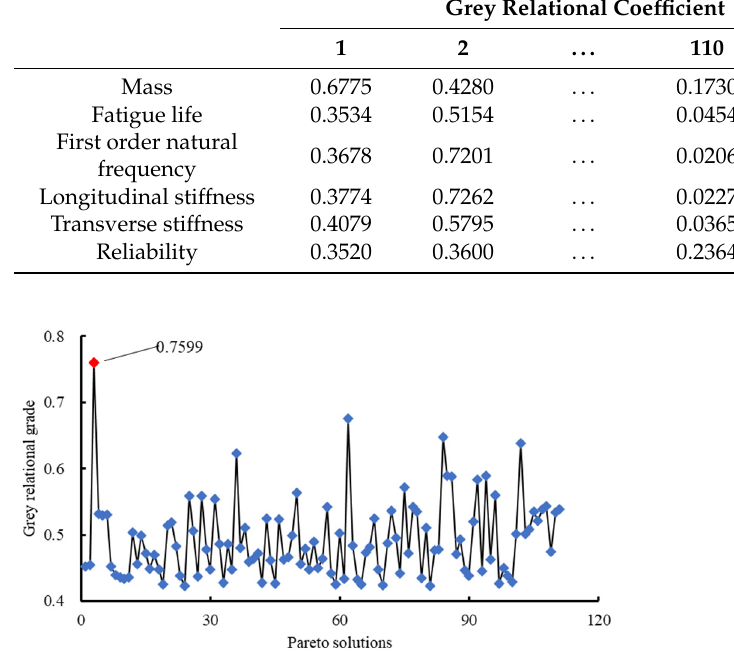
Figure 13. Grey relational grade.